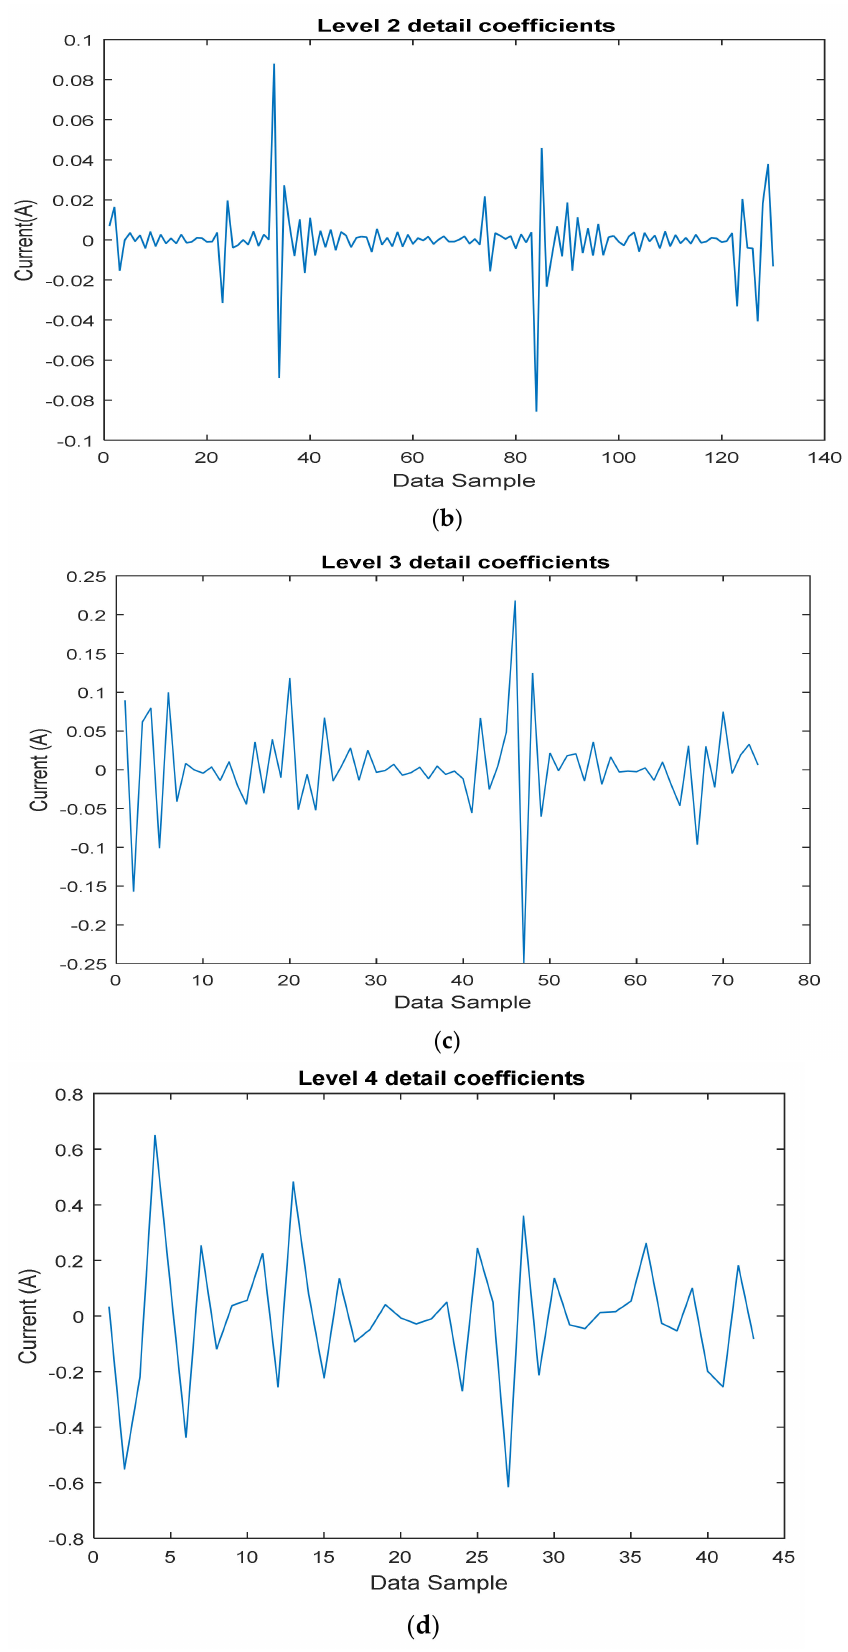
Figure 3. ( a – d ) level